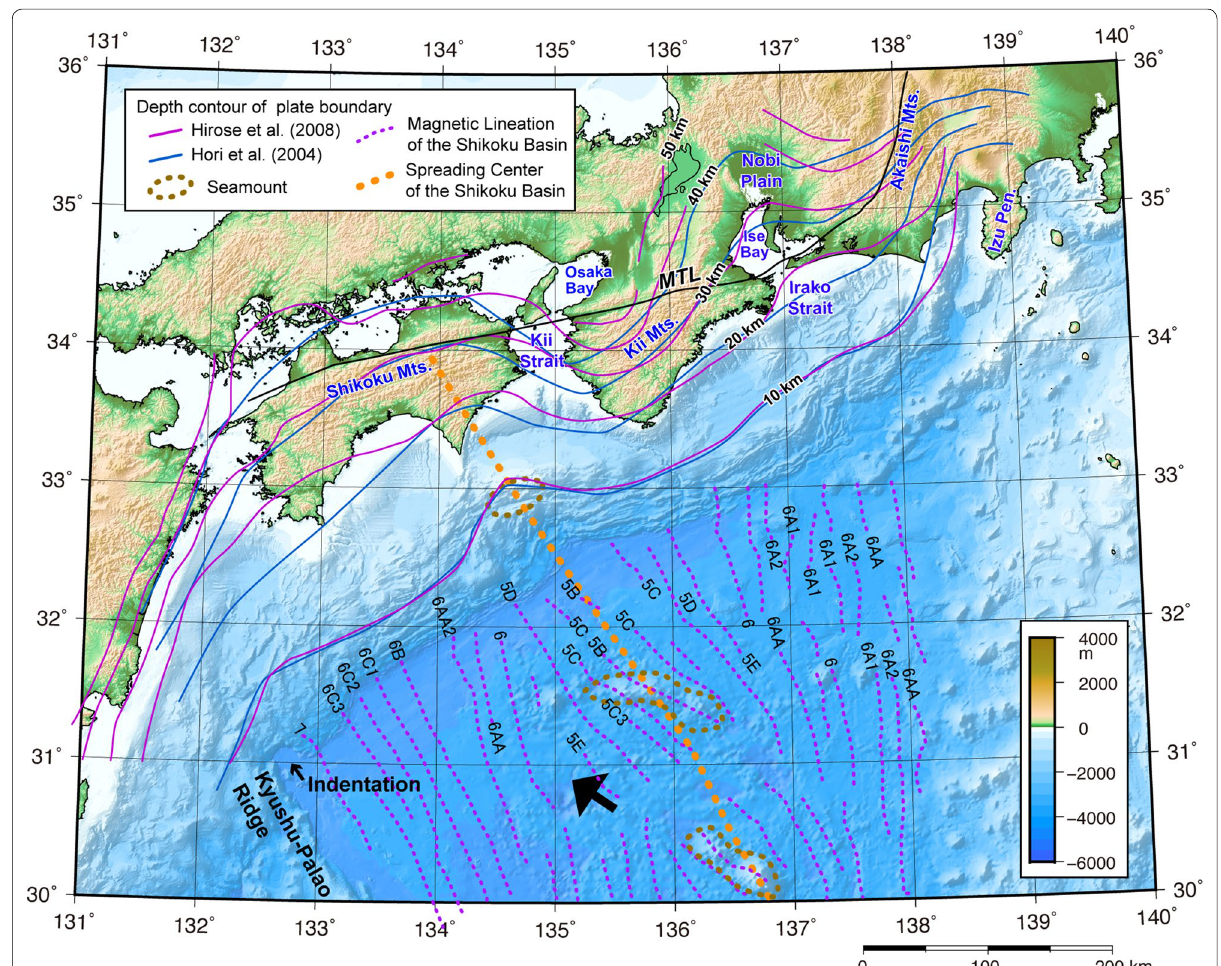
Fig. 3 Depth contours of the plate boundary (Hori et al. 2004; Hirose et al. 2008) and magnetic lineations in the Shikoku Basin (Okino 2015). The fossil spreading center of the Shikoku basin is inferred to extend beneath eastern Shikoku (orange dotted line). Seamounts (brown dotted line) are members of the Kinan Seamount Chain along the spreading